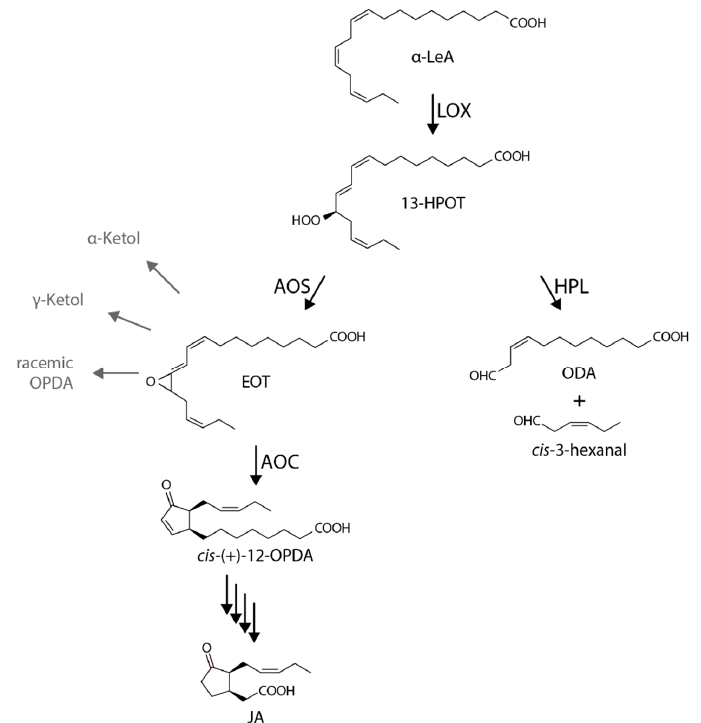
Figure 1. Biosynthesis of jasmonic acid (JA) and green leaf volatiles through the Vick and Zimmerman shunt. Pathway intermediates are given as 13-HPOT, (9 Z 11 E 15 Z 13 S )-13-hydroperoxy-9,11,15-